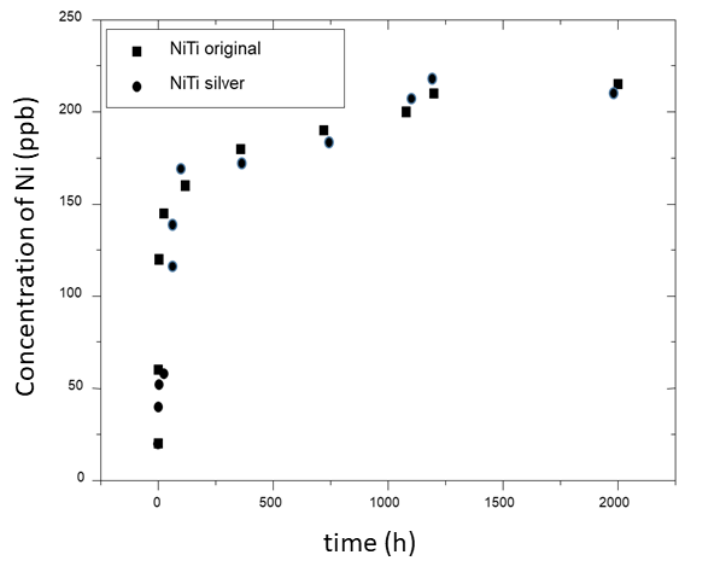
Figure 4. Nickel ion release for NiTi and NiTi with silver nanoparticles archwires analyzed at different immersion times.